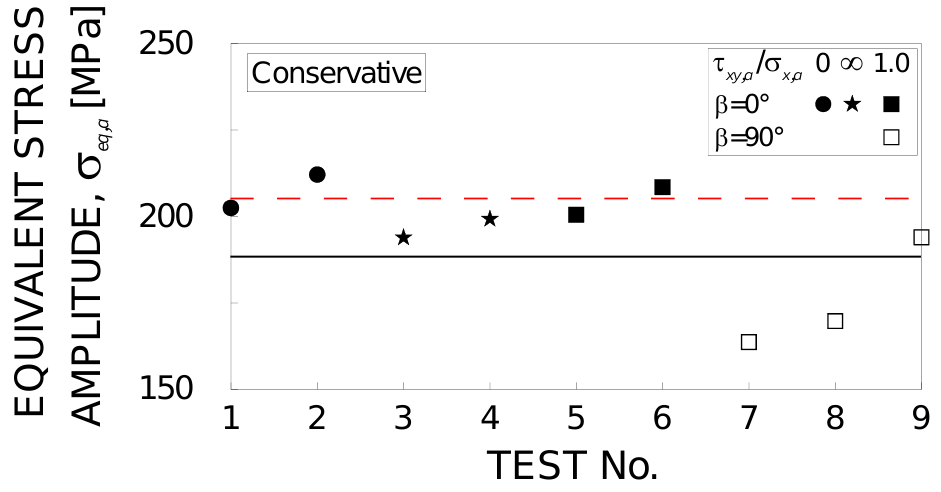
Figure 6. Equivalent stress amplitude vs. test No. computed according to the present procedure for EN-GJS-400-18 DCI.